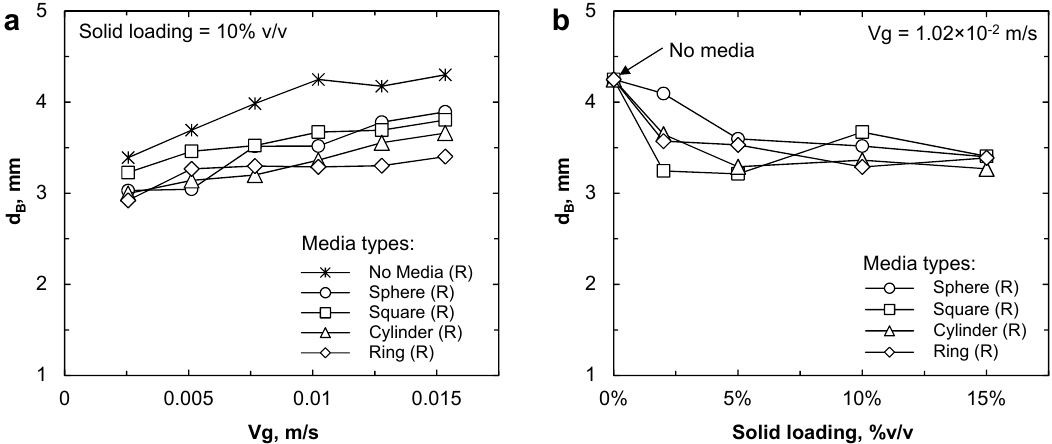
Figure 3. Mean bubble diameter (d B ) in the riser compartment of ALR for each solid media type with: ( a ) superficial gas velocity (Vg) and ( b ) solid loading.